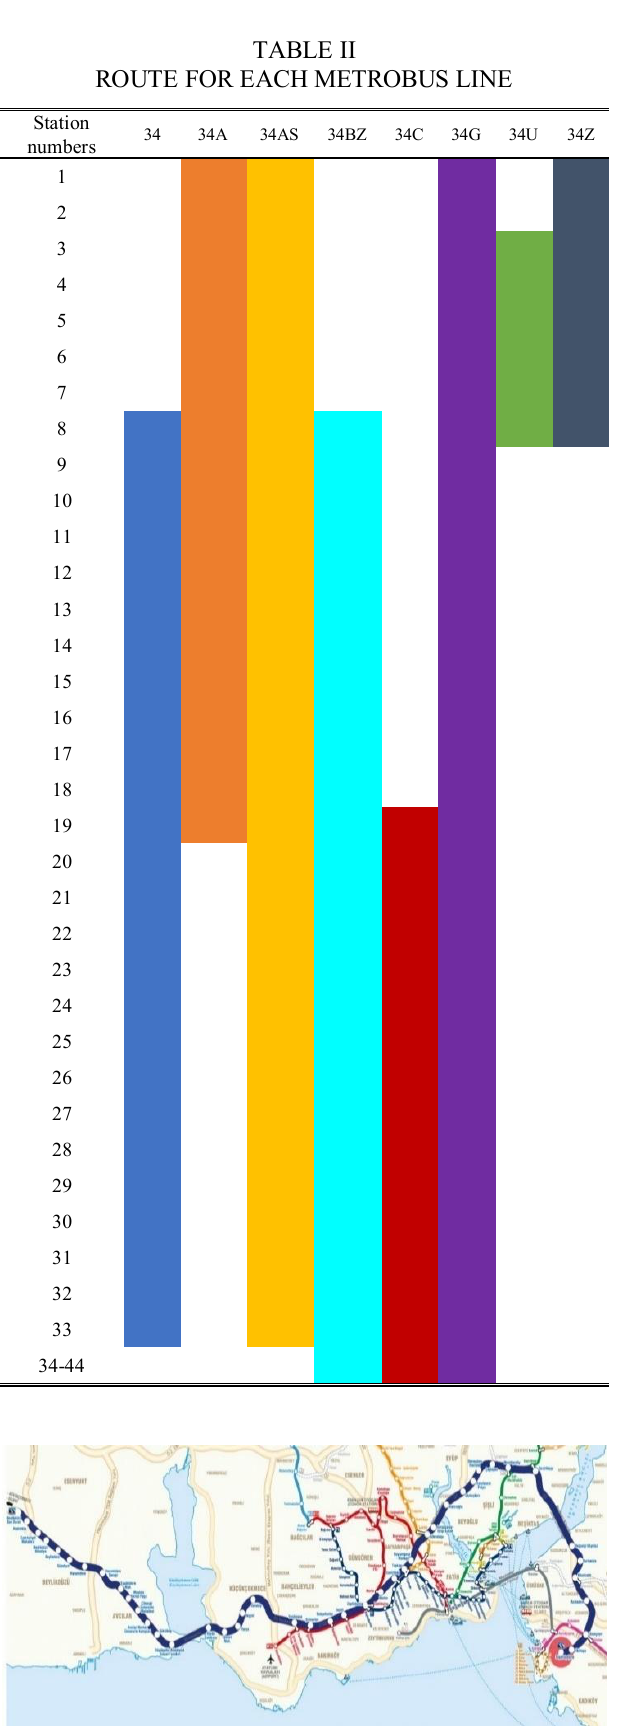
Fig. 4. Metrobus line route on the map (blue line)